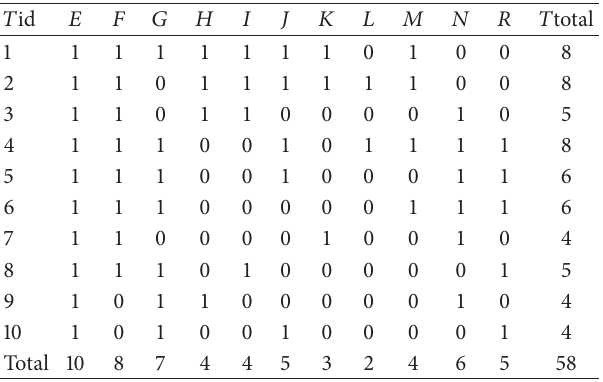
Table 1: A data set of